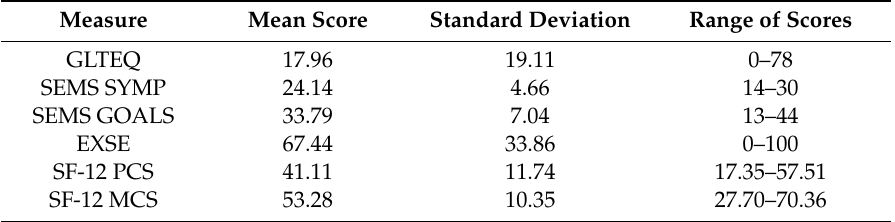
Table 1. Descriptive statistics for the variables of interest.